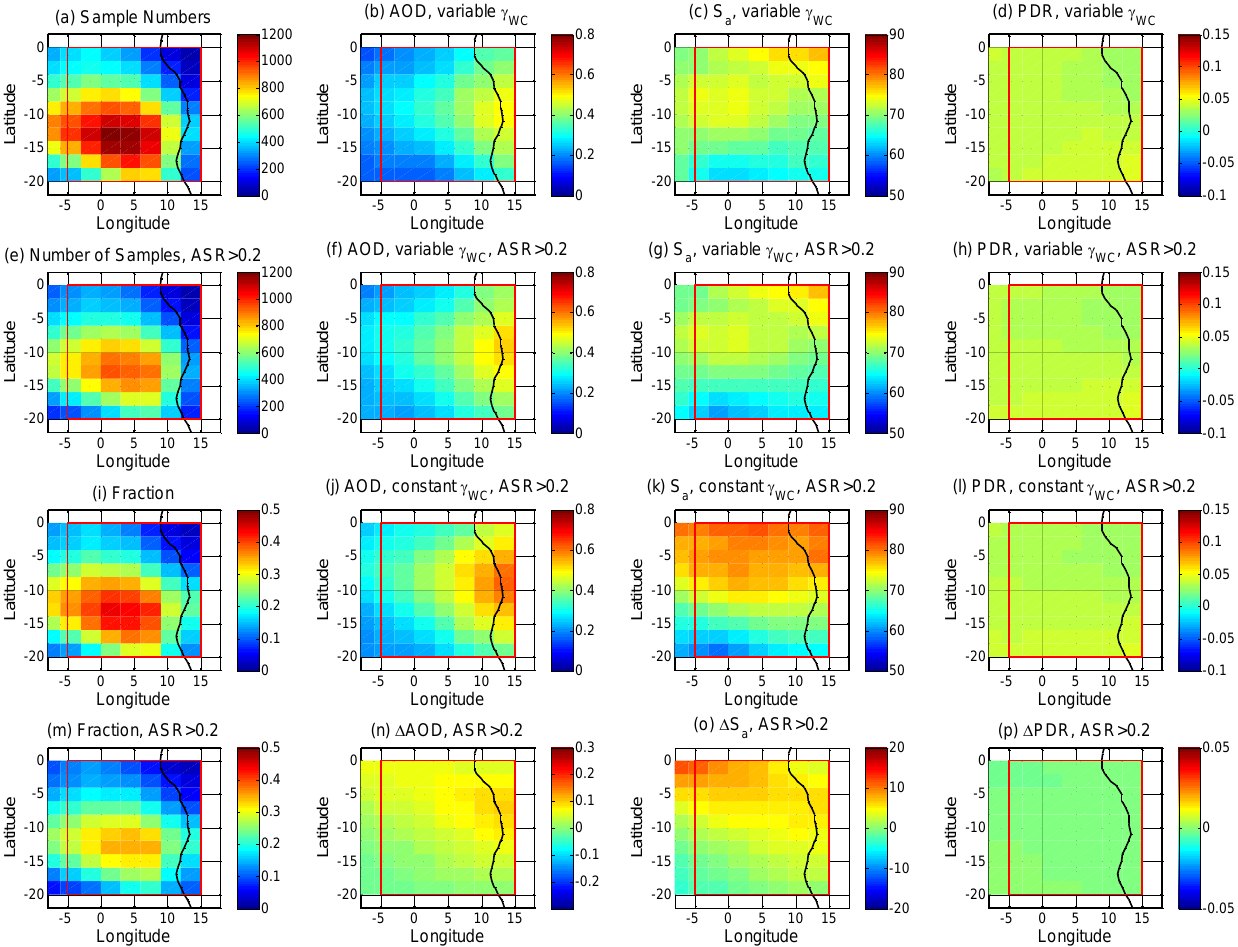
Figure 7. Analysis results in the smoke region over the eastern South Atlantic from CALIOP data acquired during the months of July– September in the years 2007–2012. (a) Number of samples, (b) AOD retrieved using the OWC technique with a location-dependent γ WC for aerosol layers located above the opaque water clouds, and (c) S a and (d) particulate depolarization ratio (PDR) retrieved using the OWC- retrieved AOD in (b) as a constraint. Shown in the second row of panels (e–h) are corresponding maps with data screening of ASR>0.2 for the overlying aerosol layers (i.e., relatively weakly scattering aerosol layers are excluded). Panels (i) and (m) show the fraction of OWC retrievals relative to the total number of measurements in each grid, respectively, for all aerosol layers and moderately dense aerosol layers. The third row of panels (j–l) are corresponding maps using a constant γ (cid:48) (0.0260sr − 1 ) averaged over the spatial domain indicated WC, SS, NA by the red box. The bottom row of panels (n–p) show the difference of the corresponding quantities retrieved using a constant γ (cid:48) WC, SS, NA and a location-dependent γ (cid:48) . The size of each grid box is 2 ◦ × 3 ◦ (lat × long). A significant location-dependent trend is seen in the WC, SS, NA smoke S a (j) retrieved using a constant γ (cid:48) WC, SS, NA